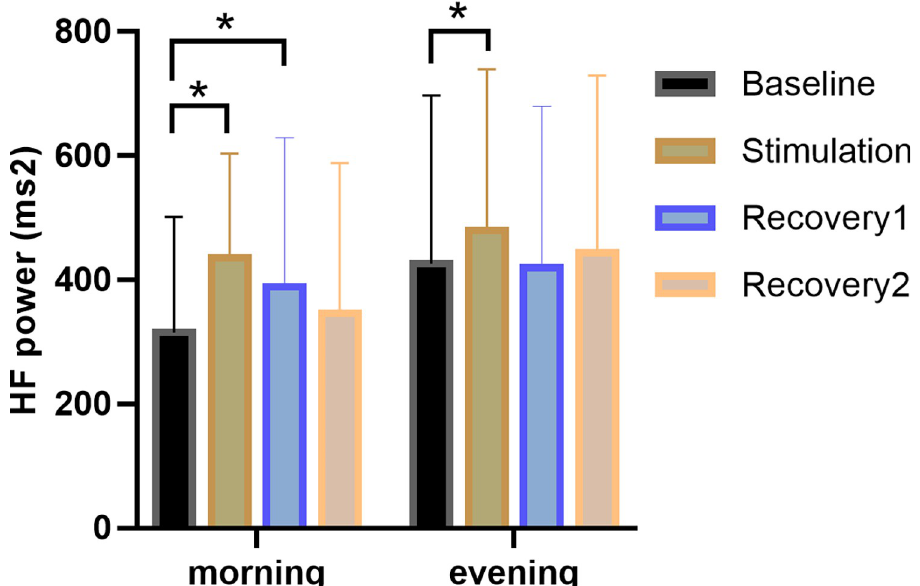
Fig 2. Changes in the HF component at different stimulation times. In the morning, the HF component increased significantly during stimulation and the first 5 min of recovery compared to baseline, whereas in the evening, only the stimulation period increased significantly compared to baseline. � = significantly different from baseline.